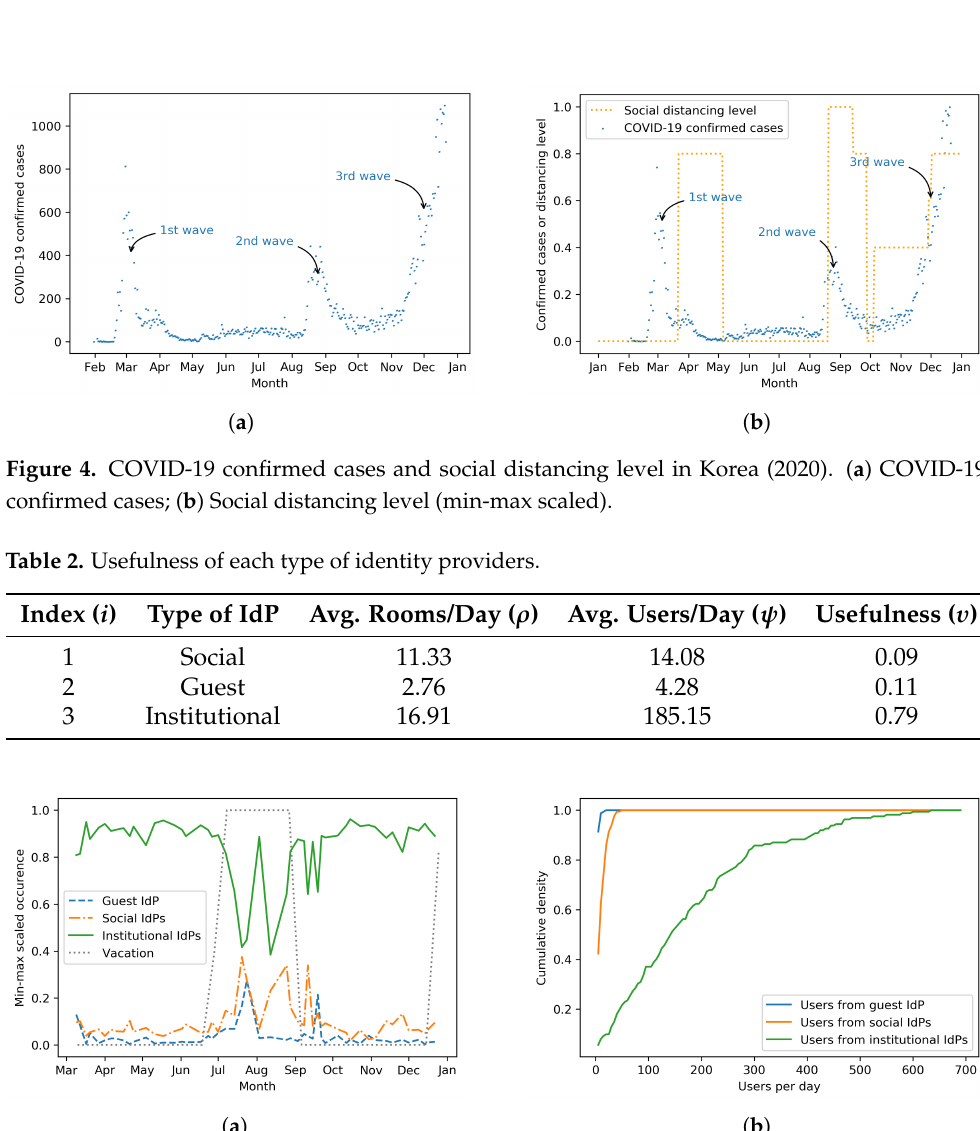
Figure 5. Usage statistics by identity management types. ( a ) Users per day (time series) ; ( b ) Users per day